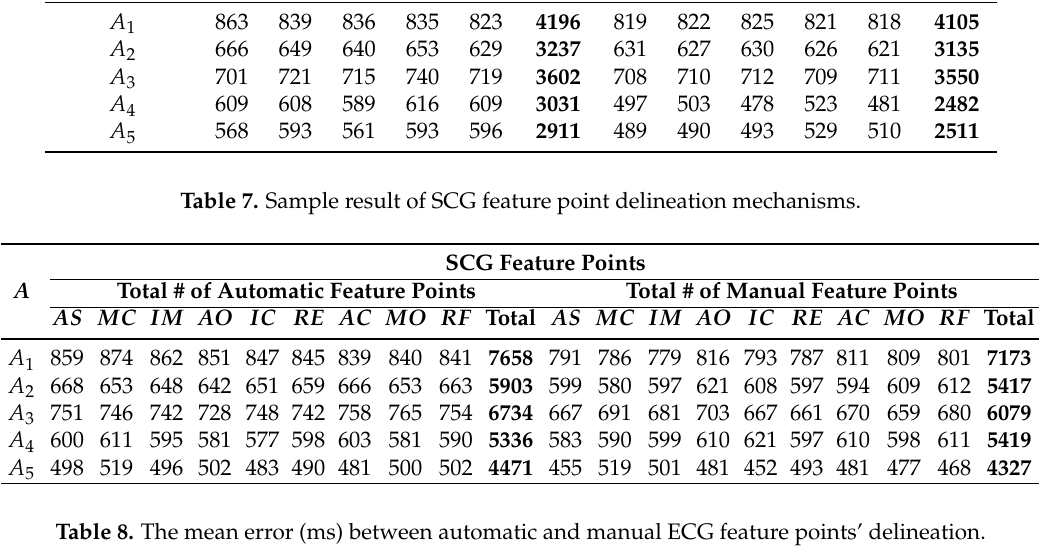
Table 8. The mean error (ms) between automatic and manual ECG feature points’ delineation.